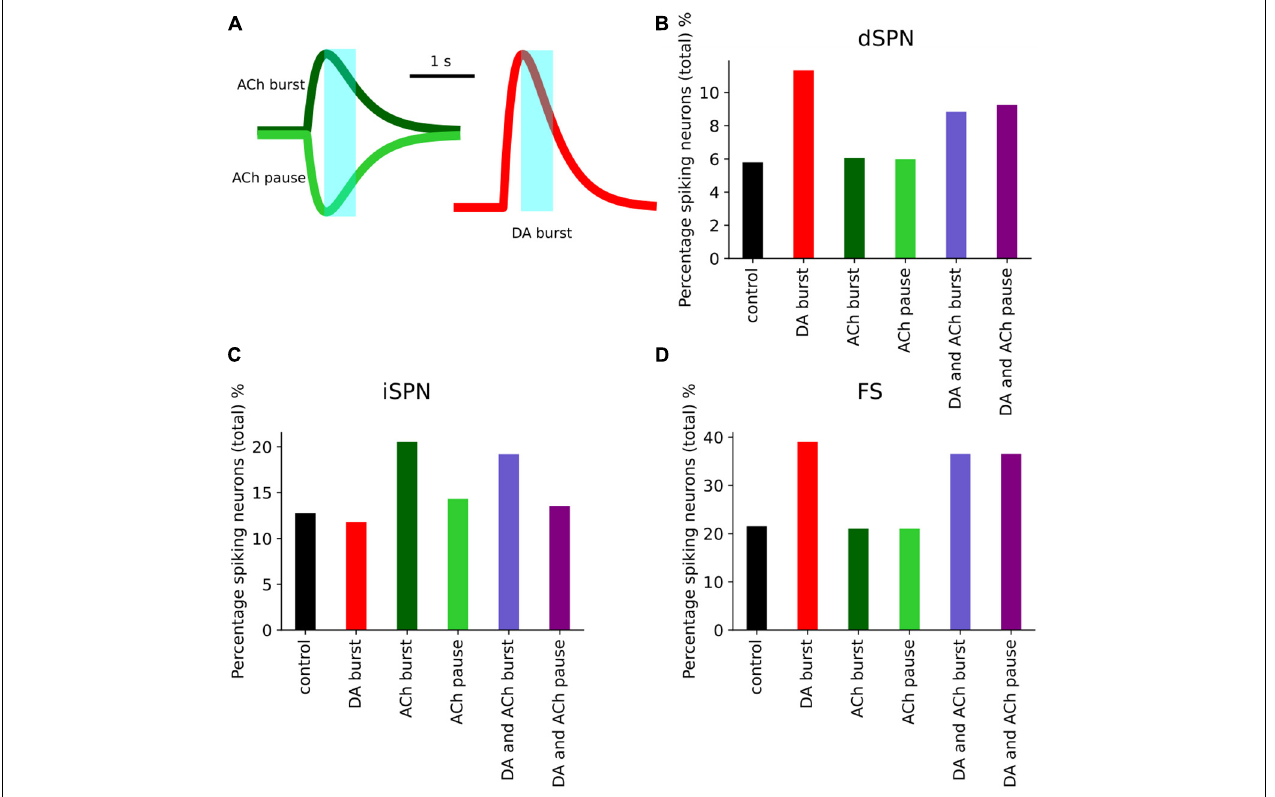
FIGURE 9 | Simulation of five neuromodulation scenarios involving dopamine and acetylcholine in a network of 10,000 neurons, 4950 dSPNs and iSPNs and 100 FS. The network received a cortical simulation at 1 s, for 500 ms. (A) Examples of the acetylcholine (ACh) burst and pause transients and the dopamine burst transient. In light blue,the timing of the cortical activation in relation to the transients. The percentage of spiking neurons are measured during the cortical simulation. (B) The response of dSPNs in the five neuromodulation scenarios (B) , dopamine (red) produced the largest effect. The acetylcholine burst and pause (light and dark green) and combinations of DA burst and ACh burst and pause (light and dark purple, respectively). (C) The response of iSPNs in the five neuromodulation scenarios and (D) the response of